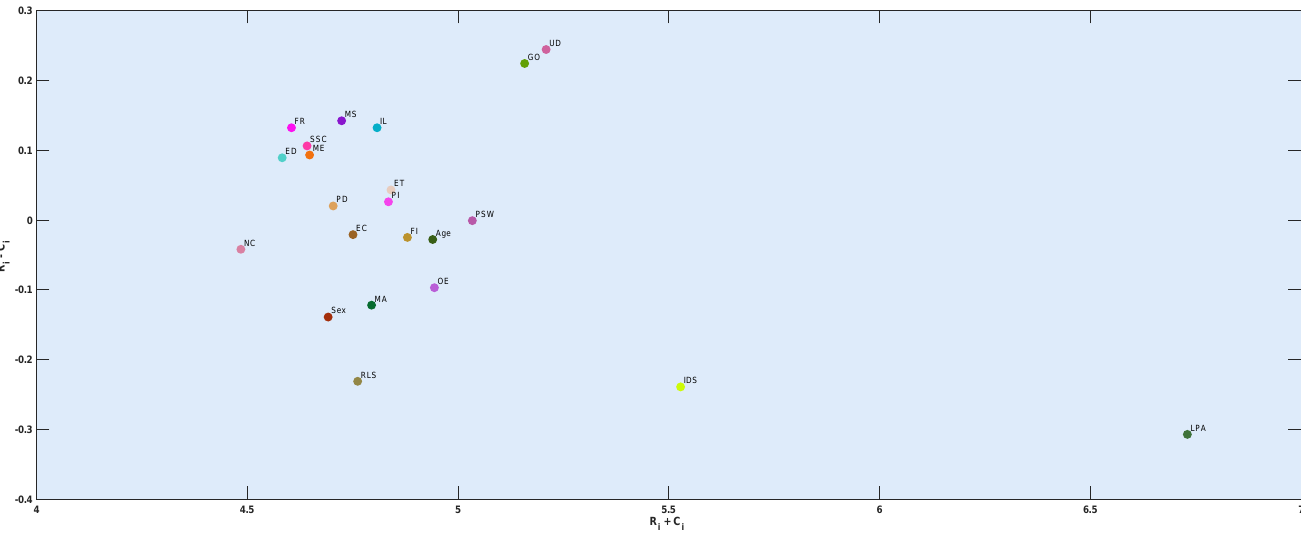
Figure 5. The interactive impact between the twenty two factors with considering of ( R i + C i ) and ( R − C ) i i